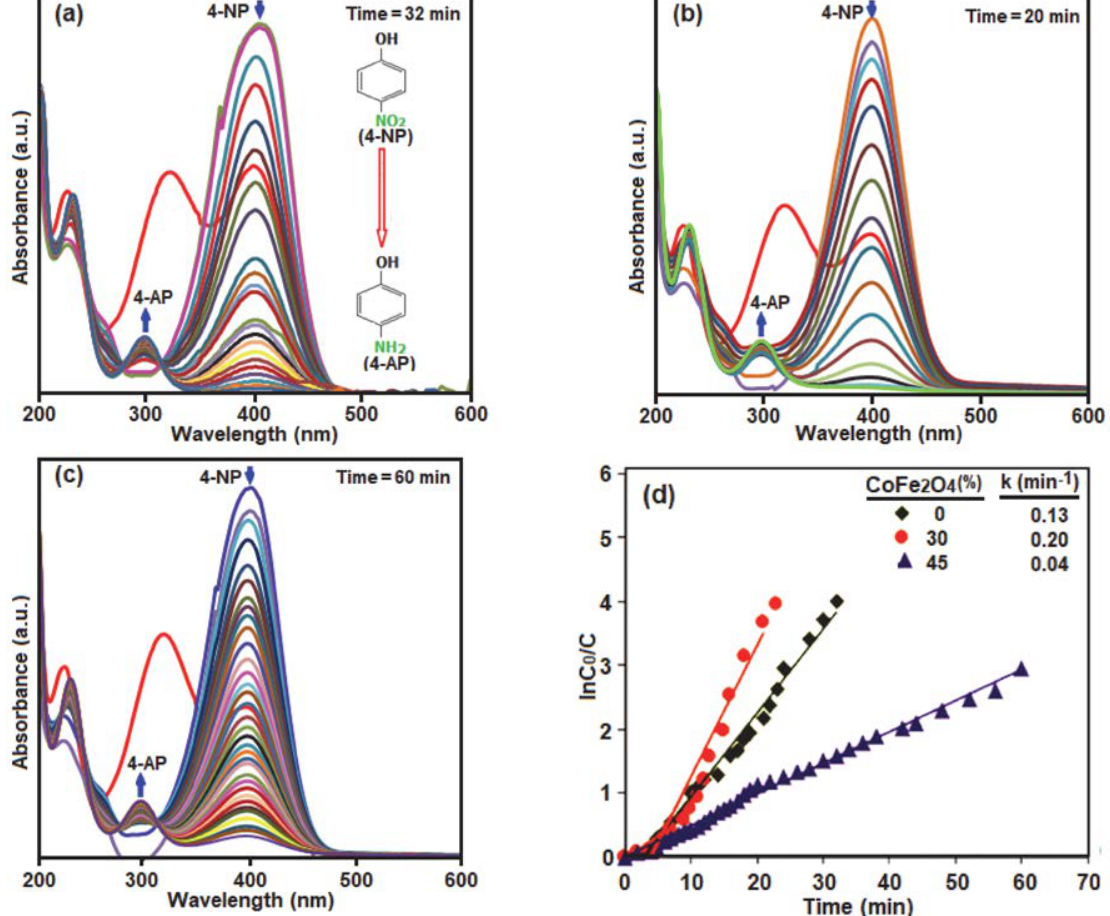
Figure 11. UV-vis spectral changes during the reduction of 4-NP with NaBH 4 over different catalysts: (a) pure Bi 2 O 2 CO 3 , (b) Bi 2 O 2 CO 3 /CoFe 2 O 4 30%, (c) Bi